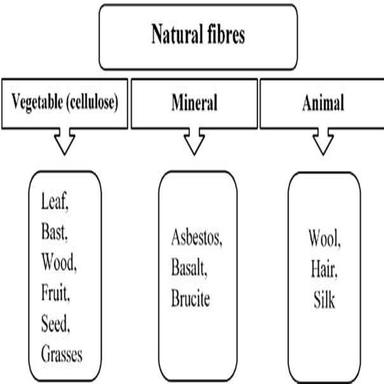
Natural fibers classification.